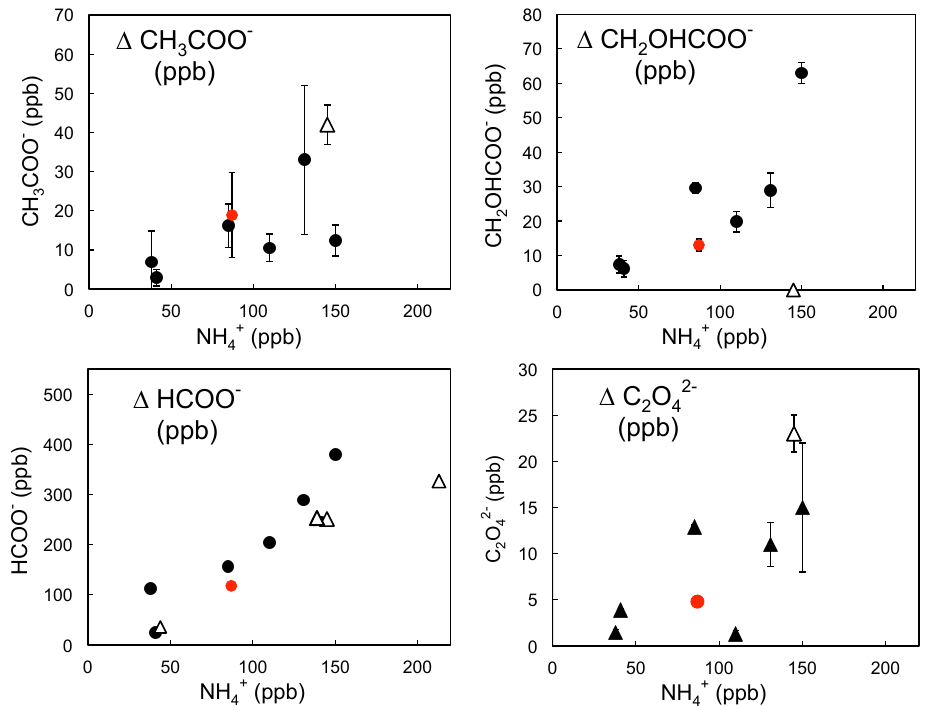
Figure 5. Enhancement of carboxylates above their background levels as a function of ammonium along several fire events detected in snow and ice layers deposited at Summit (GRIP 93 firn core and the deep GRIP ice core). HCOO − is formate, CH 3 COO − is acetate, CH 2 OHCOO − is glycolate, and C 2 O 2 − is oxalate. The black circles refer to events that occurred during the Holocene (0–11400yrBP); the 4 red dots refer to the 1908 AD event shown in Fig. 3. Open triangles correspond to four ammonium events that occurred during the Younger Dryas (11600 to 12600yrBP). For acetate and glycolate, calculation of enhancements considered the smoothing of the perturbation around the ammonium perturbation. Vertical bars are uncertainties in calculating the enhancements above background